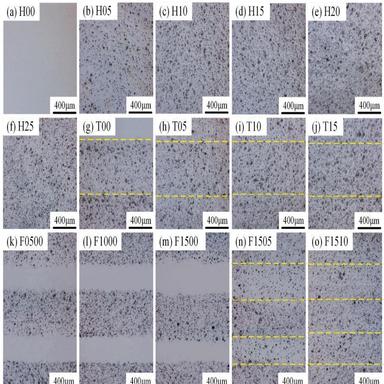
Microstructural characterization of TiB2/Al7050 HC, TiB2/Al7050 TFGM, and TiB2/Al7050 FFGM.